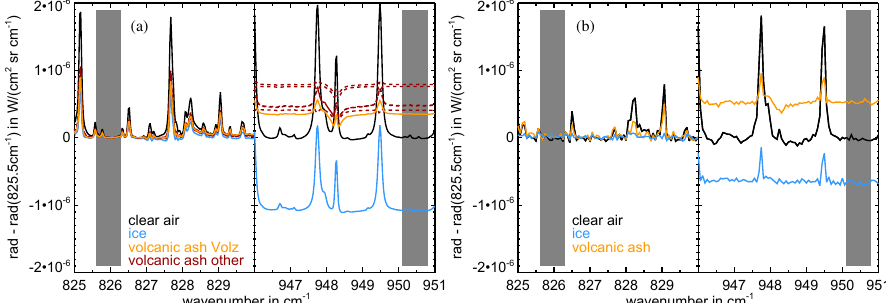
Figure 3. Simulated spectra and MIPAS measurements. (a) Pencil beam simulations for clear air, small ice particles (SVC), and small ash particles ( r eff = 1µm) at 10.0km tangent altitude in mid-latitude atmospheric conditions. (b) MIPAS measurements (orbit 48509, profiles 89, 18, 65) for clear air, ice, and 6-day-old volcanic ash from Puyehue-Cordón Caulle eruption at tangent altitudes between 10 and 11km. The spectra are levelled by subtracting the radiance at 826cm − 1 .